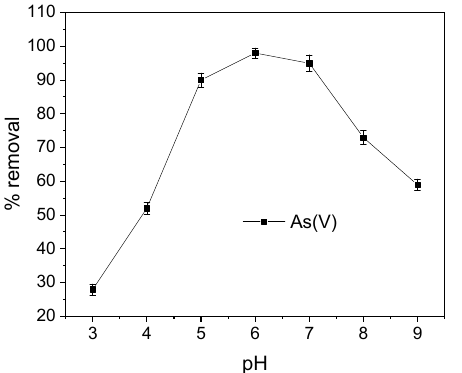
Figure 3. Effect of pH of water on percentage removal of As(V) ions using impregnated resin (at As(V) concentration of 0.1 mg/L).